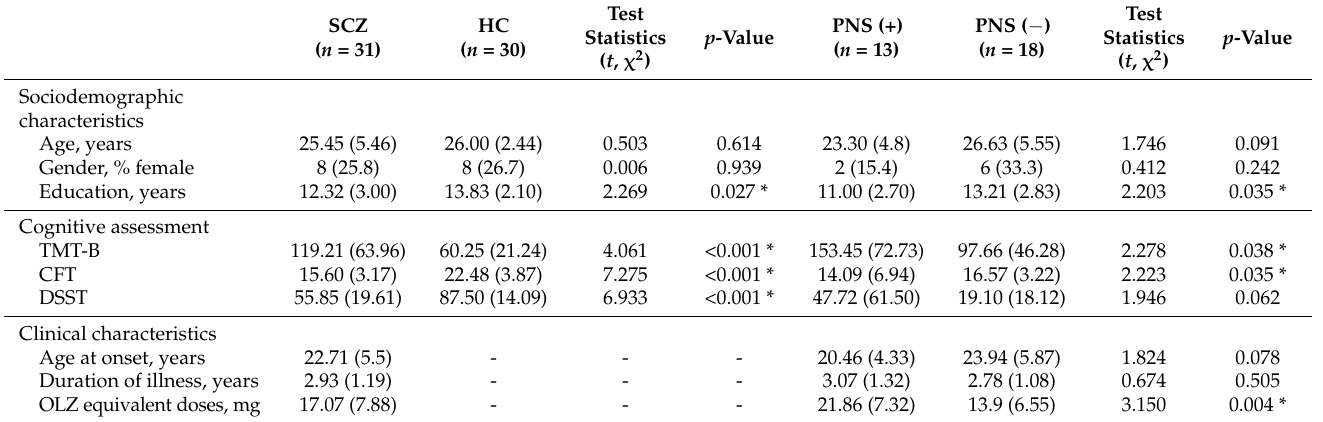
Table 1. Sociodemographic, cognitive, and clinical